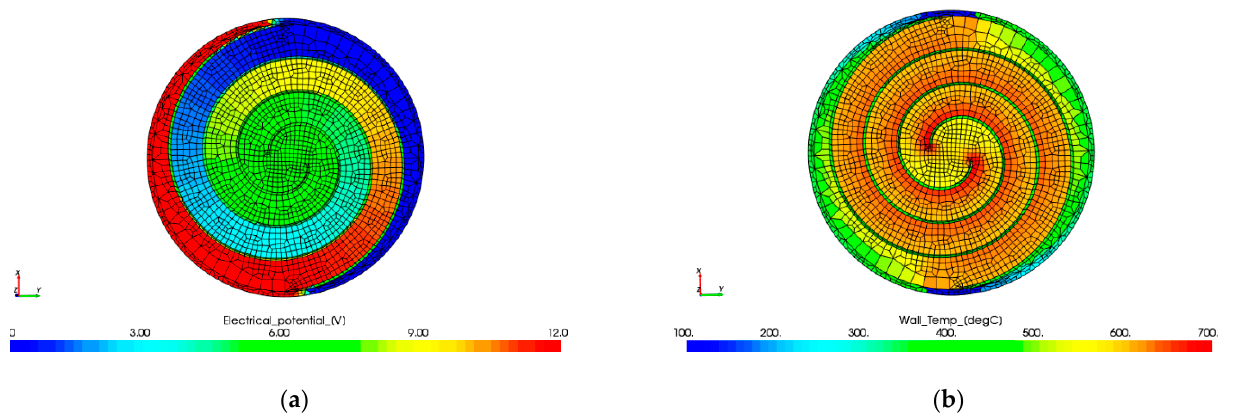
Figure 12. Indicative 12V application after supplying 2 kW of electrical power for 40 s under constant exhaust flow of 100 kg/h and gas temperature of 400 °C. ( a ) Electrical potential distribution; ( b ) Non-uniform thermal profile generated.